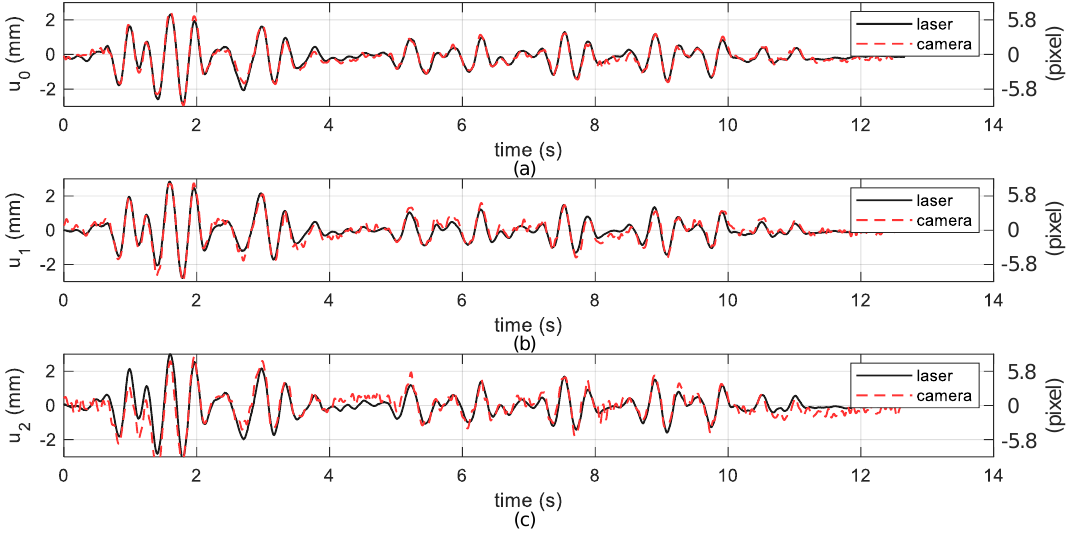
Figure 14. Measured results from the proposed method: ( a ) the base story displacement u 0 , ( b ) the first story displacement u 1 , ( c ) the second story displacement u 2